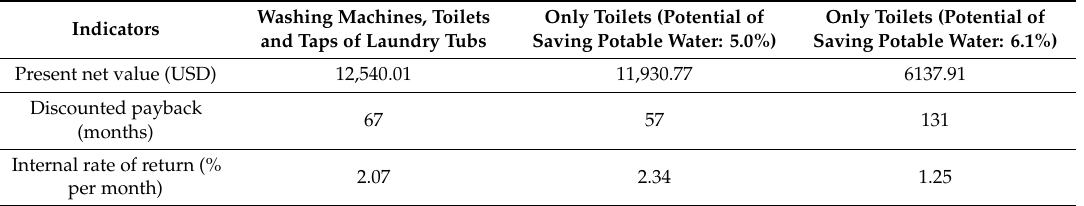
Table 8. Analyses conducted for di ff erent potentials for saving potable